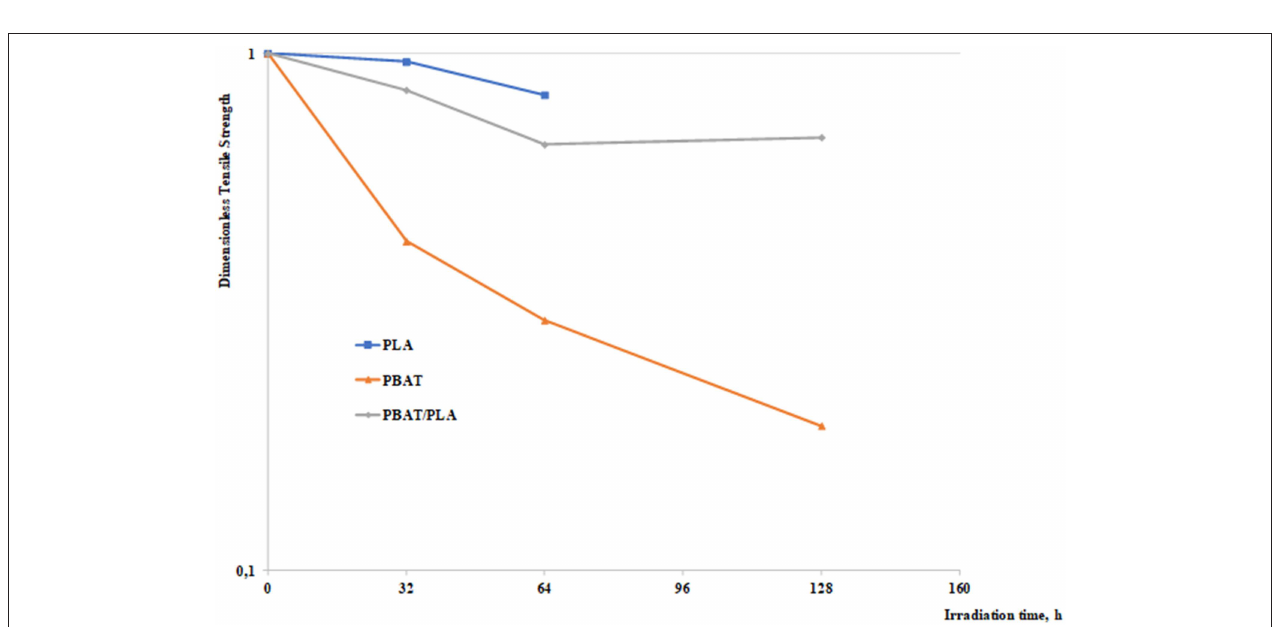
FIGURE 7 | Dimensionless tensile strength as a function of the irradiation time.